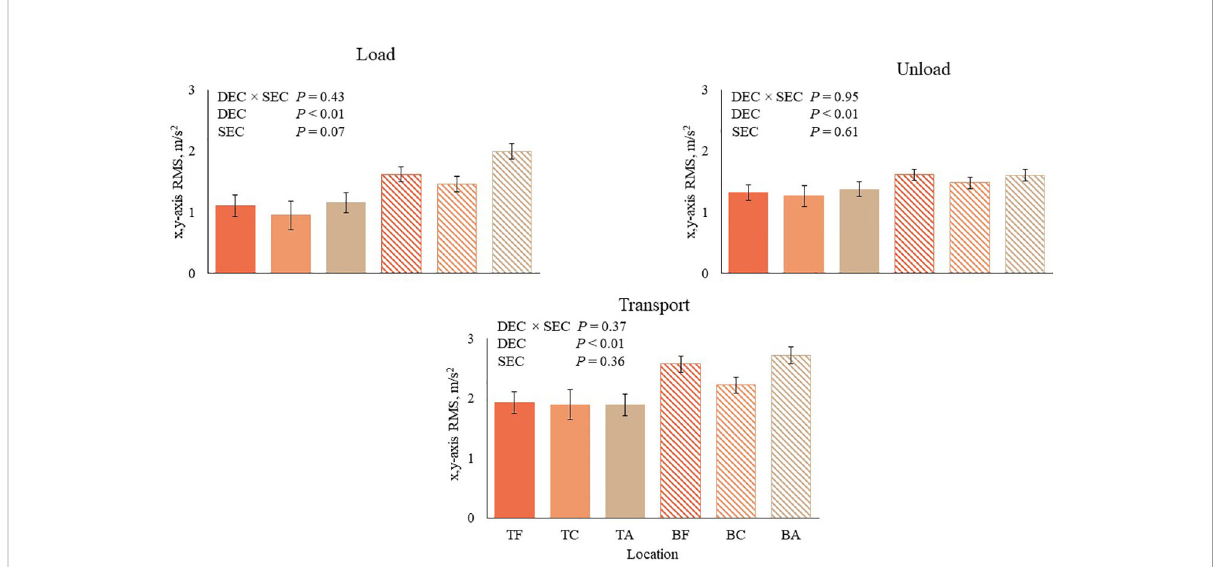
FIGURE 2 Weighted x,y-axis root mean square (RMS) experienced by pigs transported within two decks (DEC; T, Top; B, bottom) and three sections (SEC; F, fore; C, center; A, aft) located within two trailers during loading, transport, and unloading. Two trailers transported two daily market-weight pig loads over 5 consecutive days.